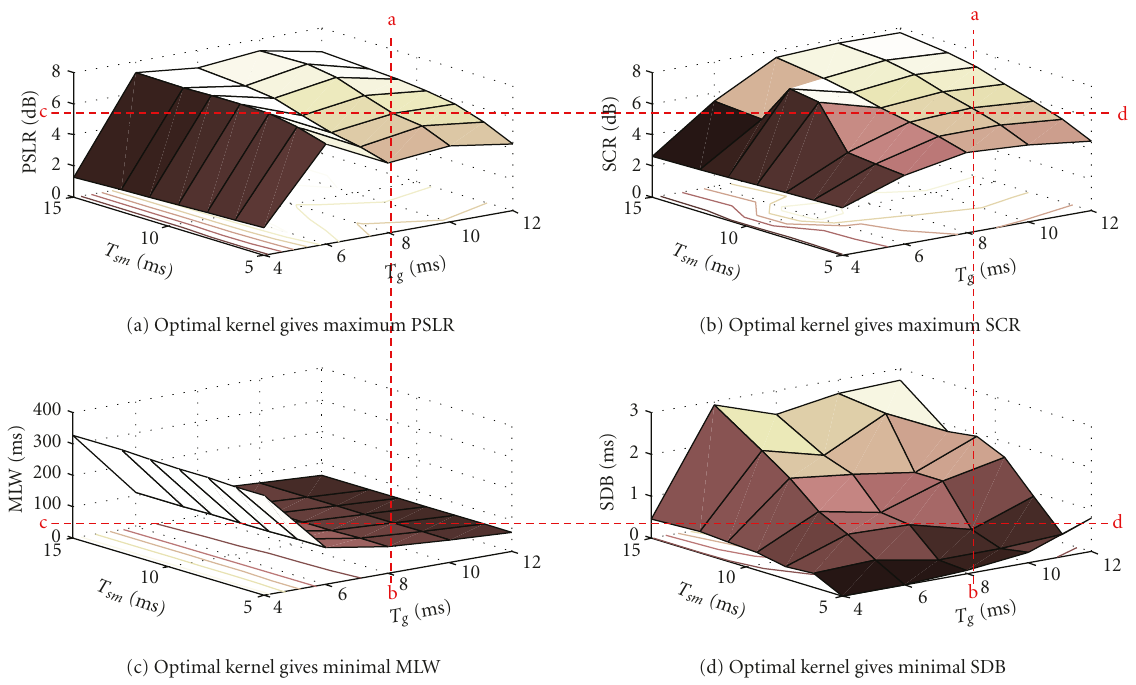
Figure 5: Performance of the TFR of FSK3 using various kernel parameters. (The optimal kernel is chosen from the kernel parameters that give small MLW and small SDB but large PSLR and large SCR,